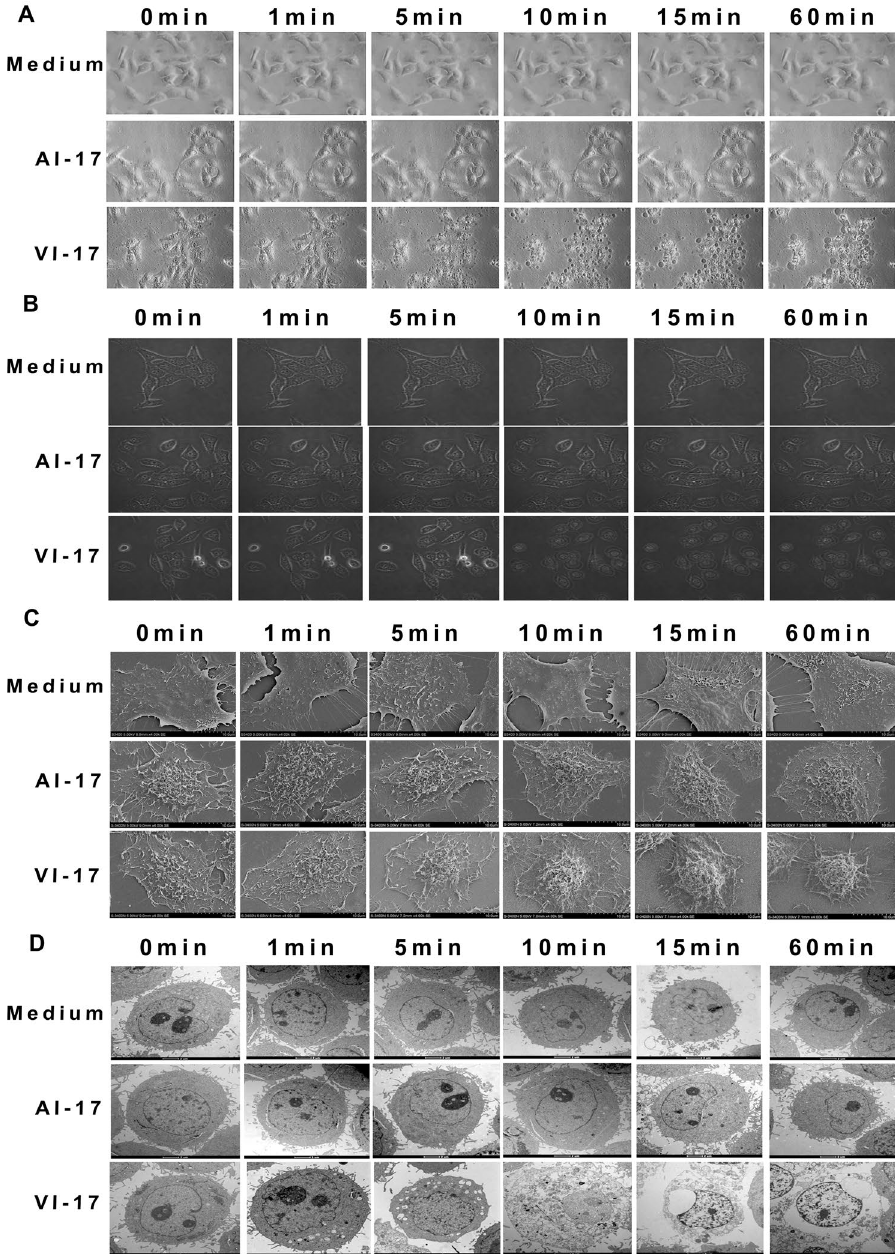
Figure 5. Morphological changes of VI-17 induced oncotic cell death. (A) Cell morphological changes observed by inverted microscopy. Original magnification: × 200. (B) Cell morphological changes observed by confocal microscopy at indicating time points. Original magnification: × 120. (C) Cell morphological changes observed by scanning electron microscopy at indicating time points. Original magnification: × 4000. (D) Cell morphological changes observed by transmission electron microscopy at indicating time points. Original magnification: ×